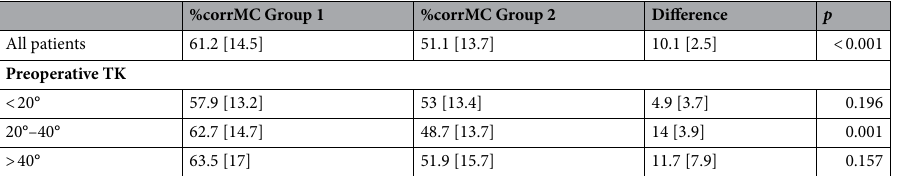
Table 10. Percent of correction of main coronal curve between Group 1 and Group 2; all patients and patients subgroups according to preoperative thoracic kyphosis; mean [standard deviation]; analysis performed